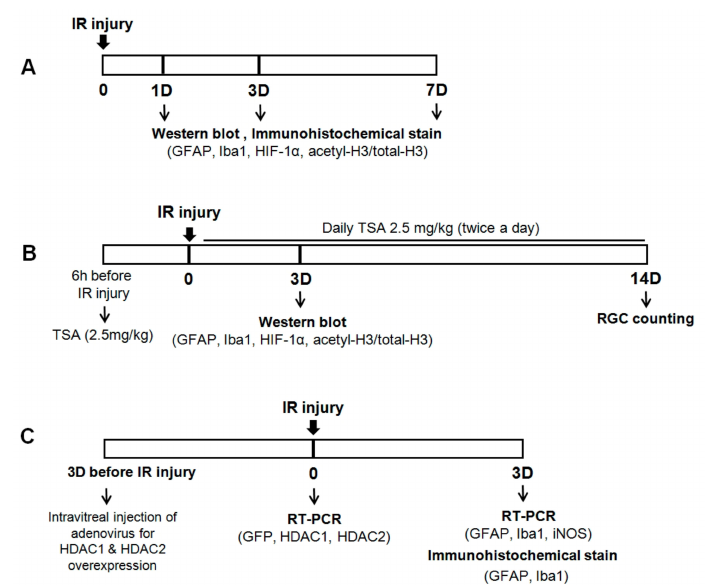
Figure 7. Schematic representation of experimental protocols in this study. Each arrow indicates a procedural time point. ( A ) To investigate retinal changes after IR injury, retinal tissue was obtained at 1, 3, and 7 days after IR injury. ( B ) To investigate the e ff ect of TSA after IR injury, TSA (2.5 mg / kg) was injected intraperitoneally 6 h before retinal IR injury and twice daily after retinal IR injury. Retinal tissue was obtained at 3 and 14 days after IR injury. ( C ) To evaluate whether HDACs activity is associated with glial cell activity, HDAC1 and HDAC2 adenovirus was intravitreally injected 3 days before IR injury. Retinal tissue was obtained at 3 days after IR